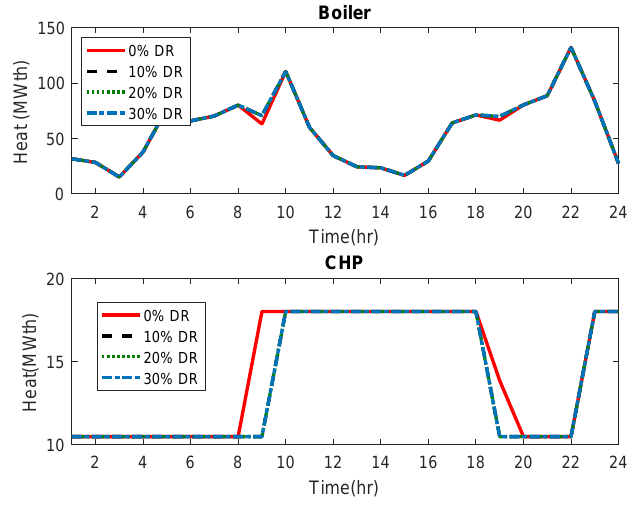
Figure 11. The heat generated by the boiler and the CHP.